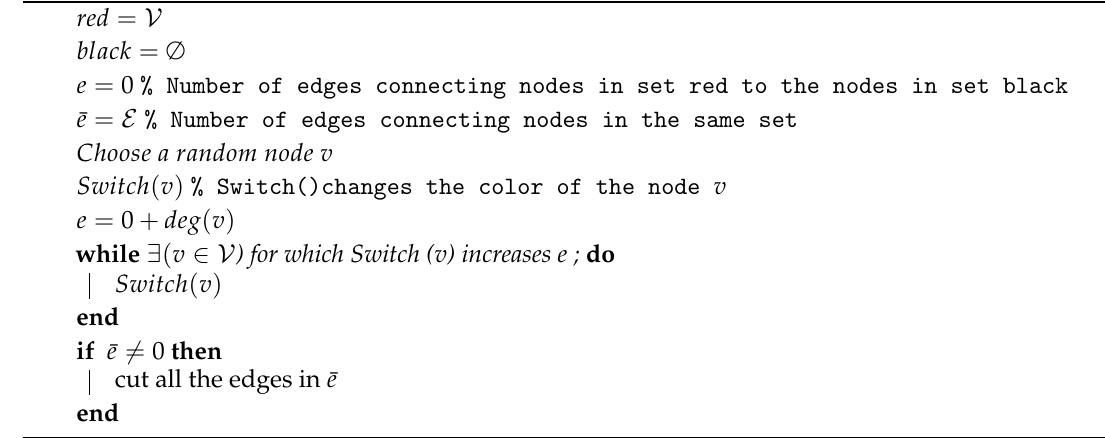
Algorithm 1: Node coloring algorithm to convert unipartite graph into bipartite graph red =